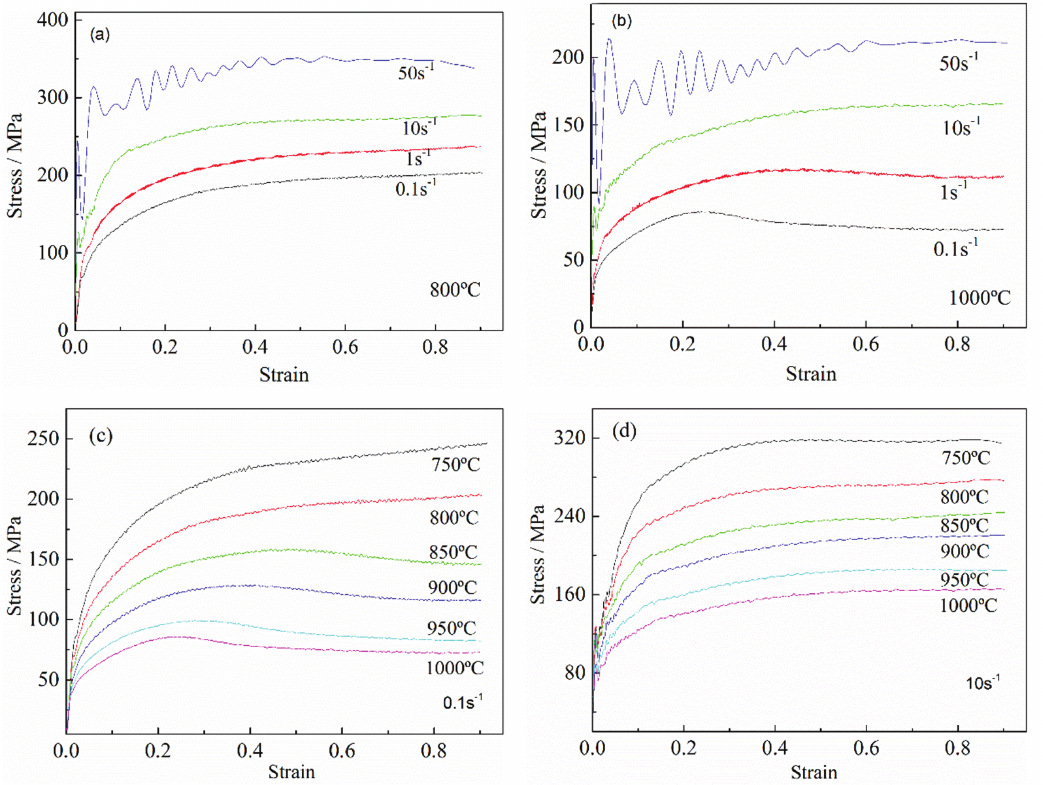
Figure 2: True stress-strain curves of 49MnVS3 non-quenched and tempered steel obtained under different deformation